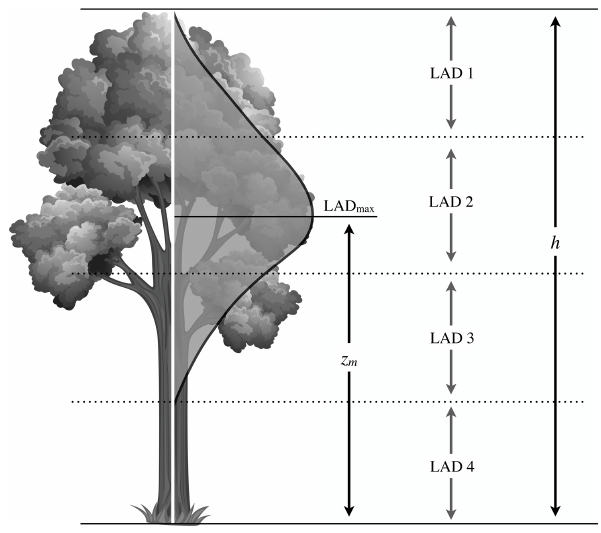
Figure 3. Graphical representation of the canopy LAD distribution. LAD max is the maximum LAD within the canopy, z m is the height from the ground at which LAD max occurs, and h is the total canopy height. LAD 1, LAD 2, LAD 3 and LAD 4 are four equal canopy